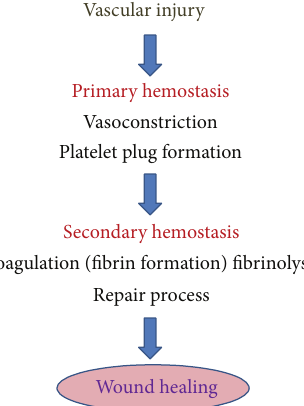
Figure 3: Pathway illustrating hemostasis.